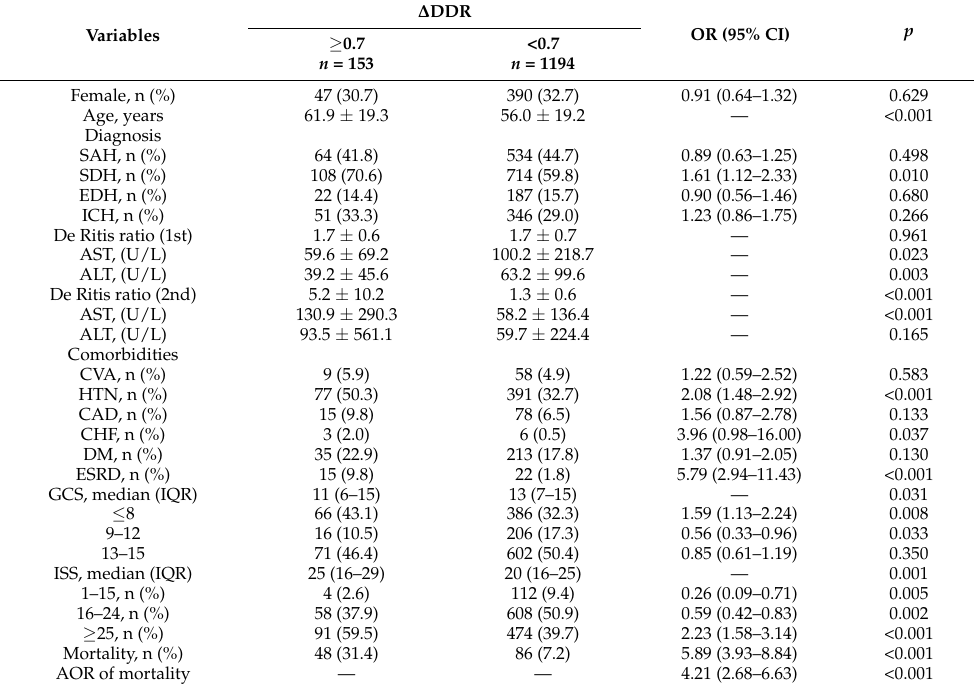
Table 4. Comparison of the injury, characteristics and outcomes of patients with a ∆ DDR ≥ 0.7 vs. those with a ∆ DDR <